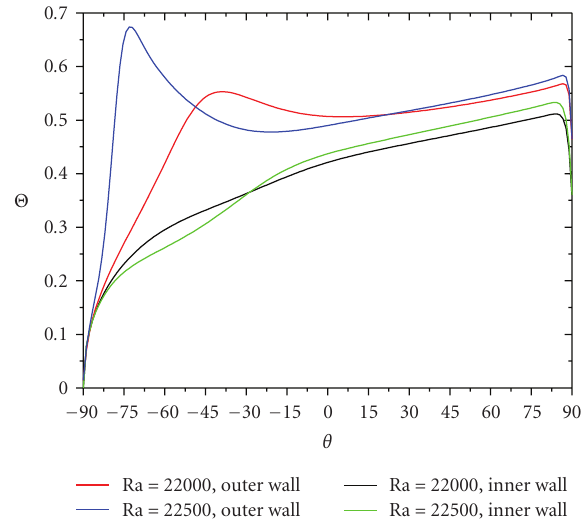
Figure 7: Inner and outer walls temperature at the heater; R = 1 . 6, Pr =